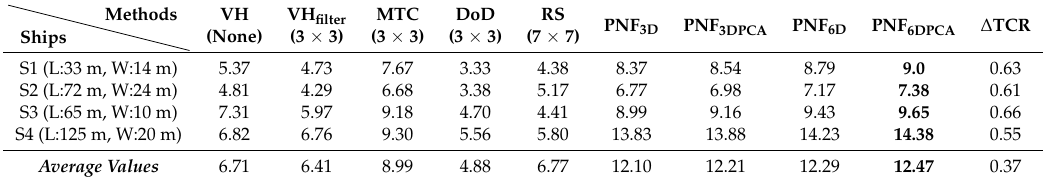
Table 3. TCR values of smaller ships and average TCR values of 19 ships of B (dB).